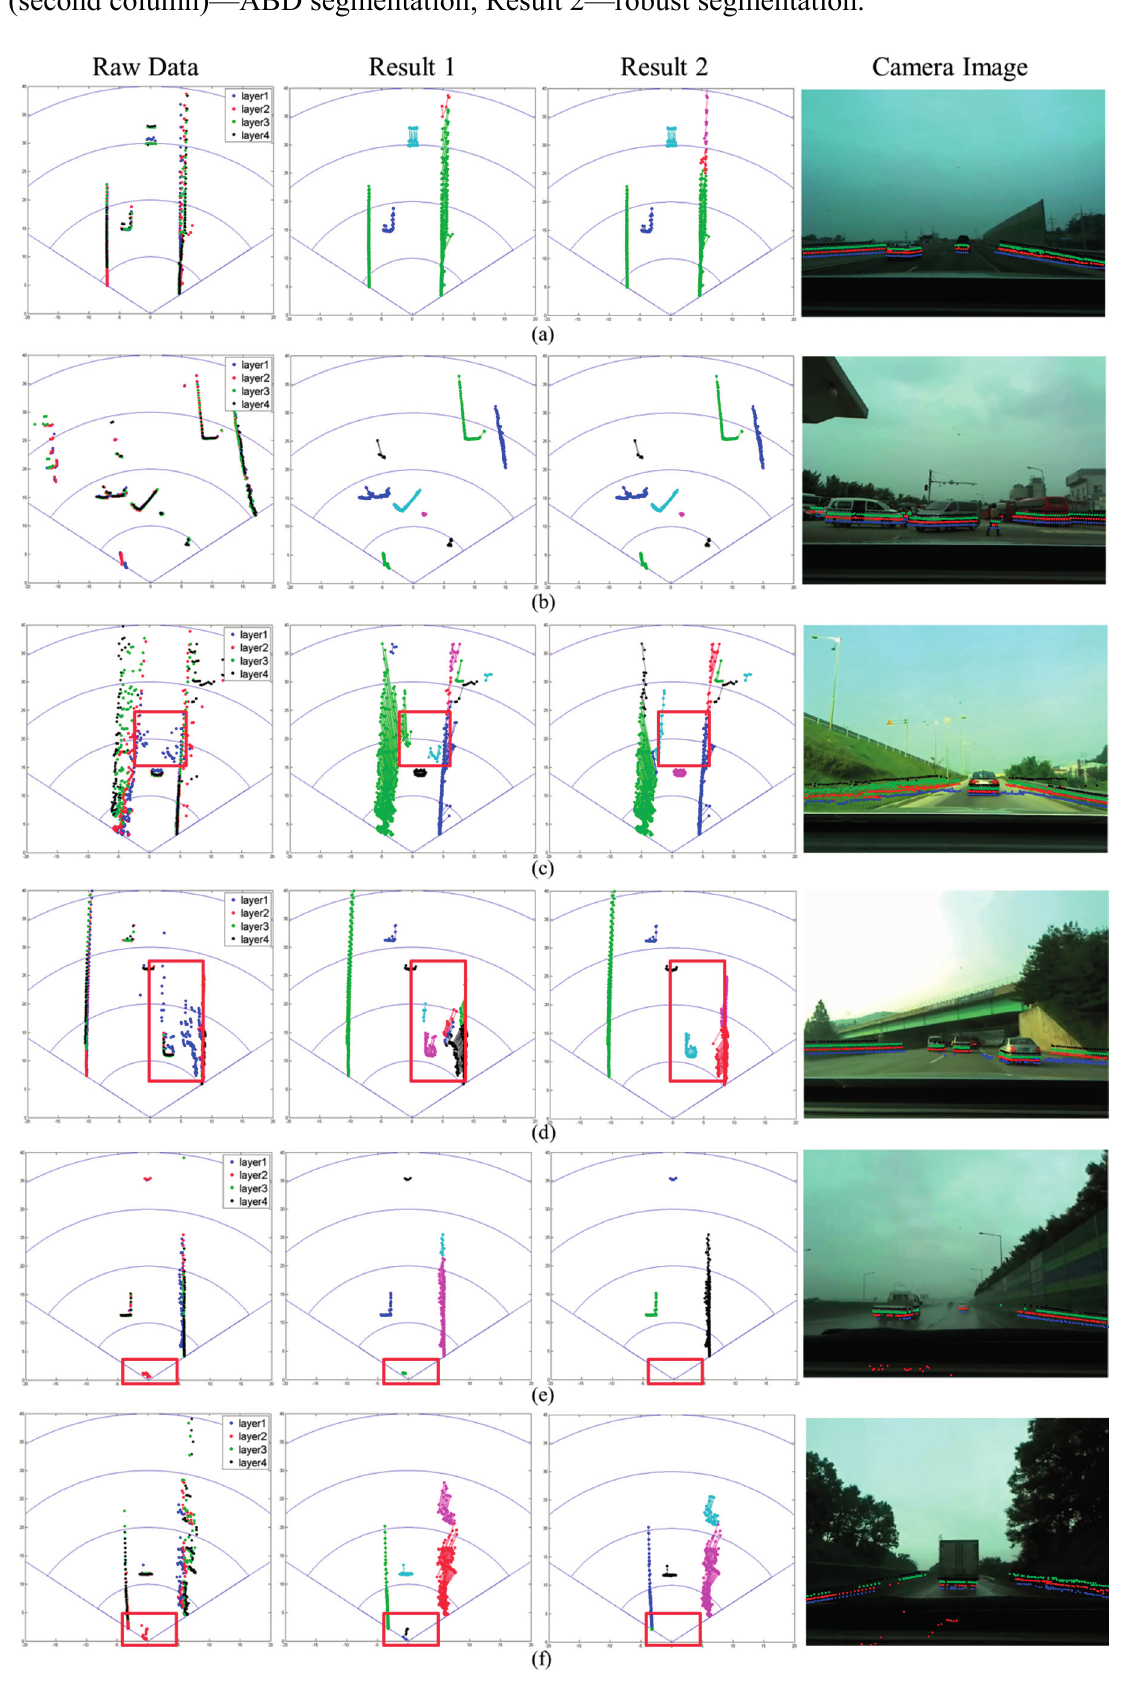
Figure 11. Segmentation results: ( a ) vehicle; ( b ) pedestrian; ( c ) ghost in uphill road; ( d ) ghost in flat road; ( e ) ghost created by rain; and ( f ) ghost created by fog. Result 1 (second column)—ABD segmentation; Result 2—robust